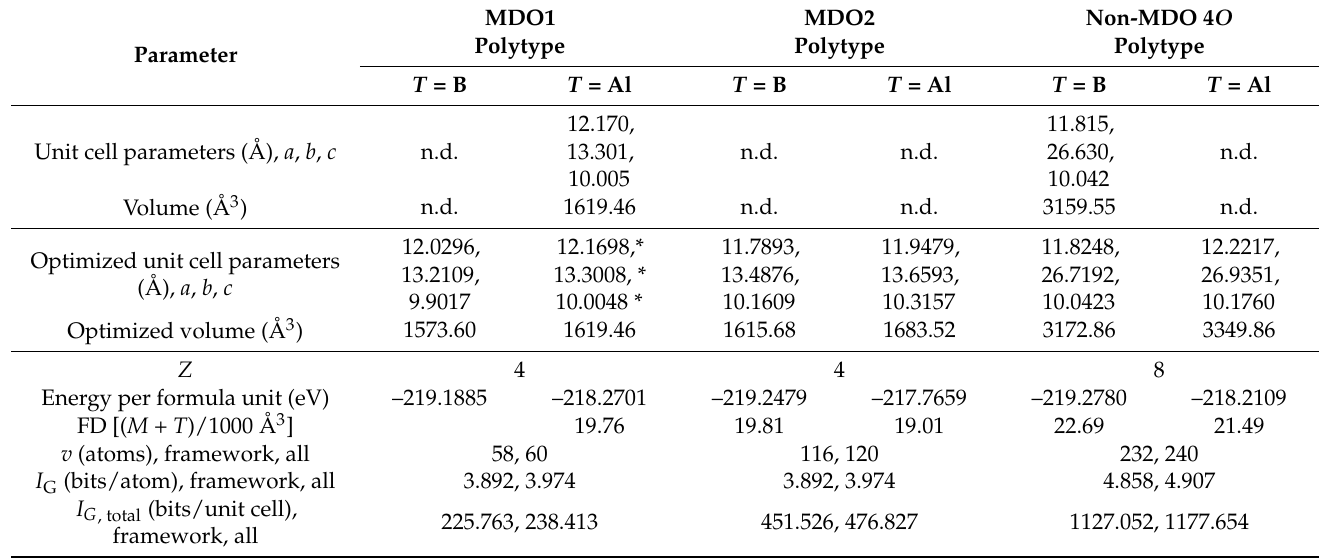
Table 3. Comparative data for the frameworks of different